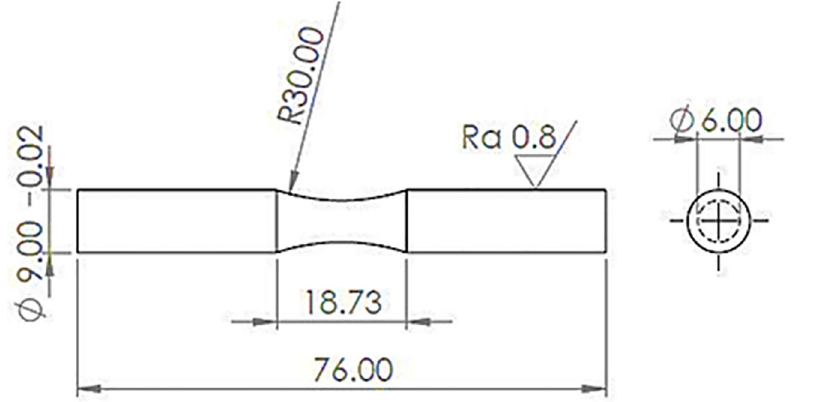
Fig 1. The standard sample dimension (millimeters) for pure and fretting fatigue testing.